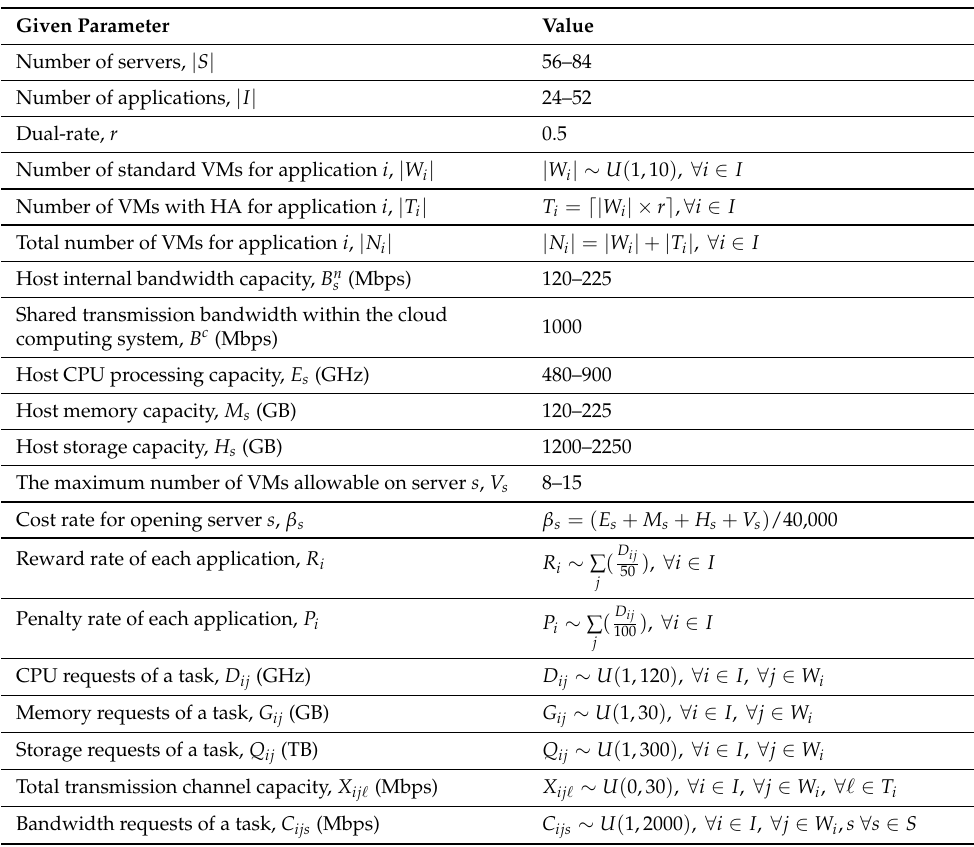
Table 6. Given parameters for the